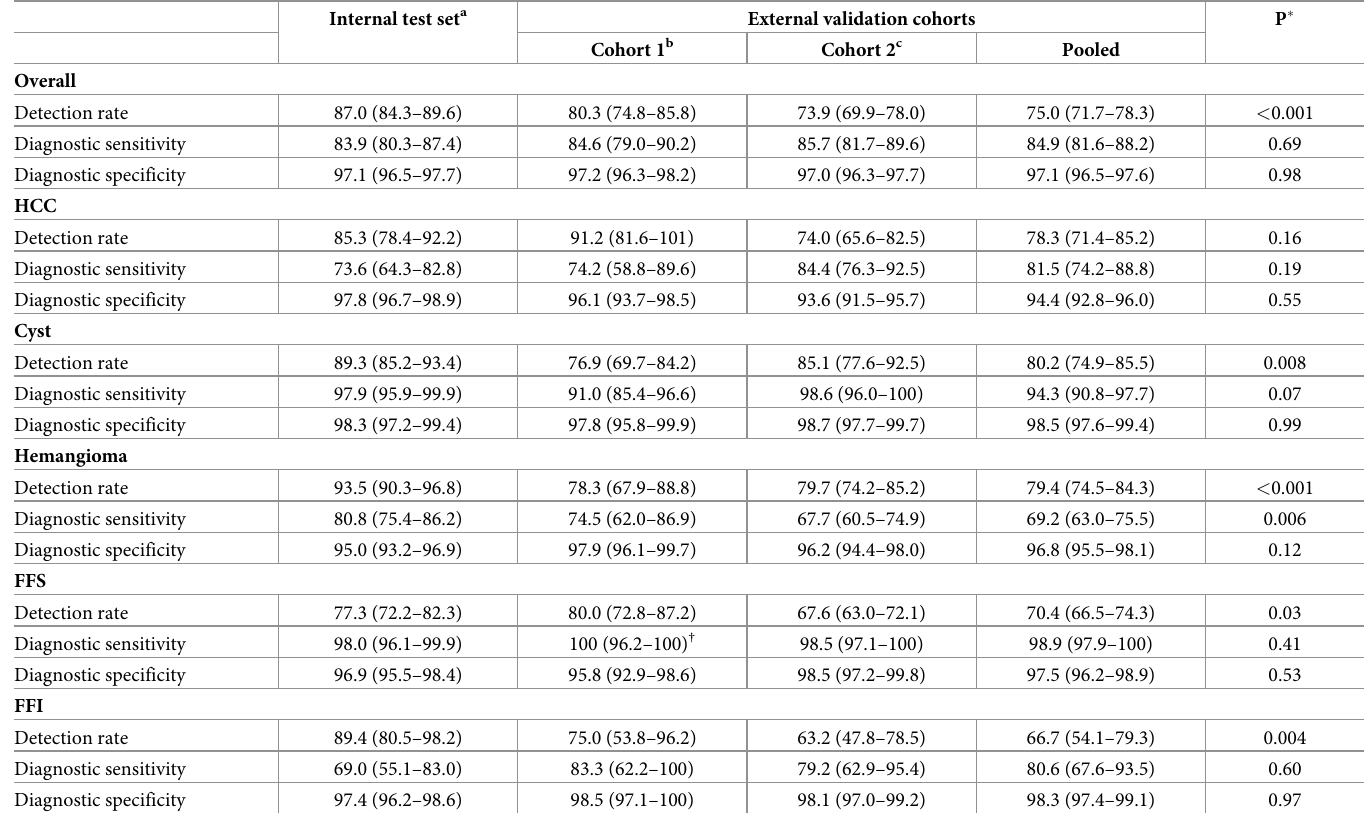
Table 2. Performance of the AI system on the internal test set and external validation